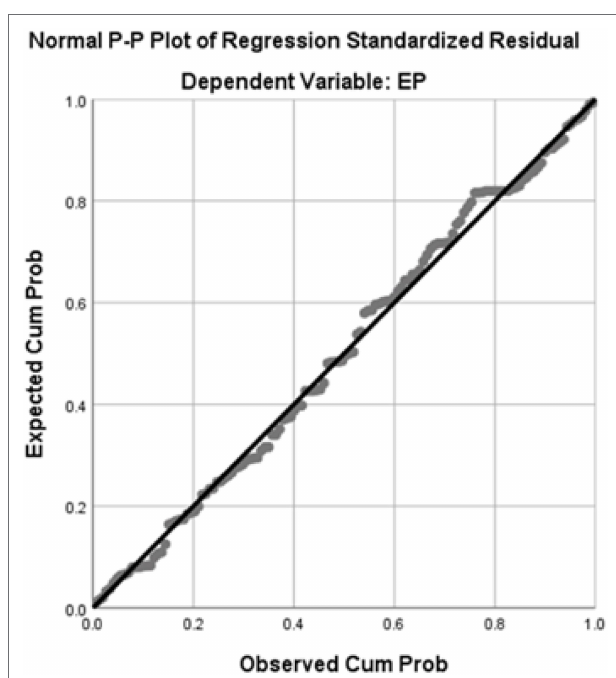
FIGURE 2 | Normality test.